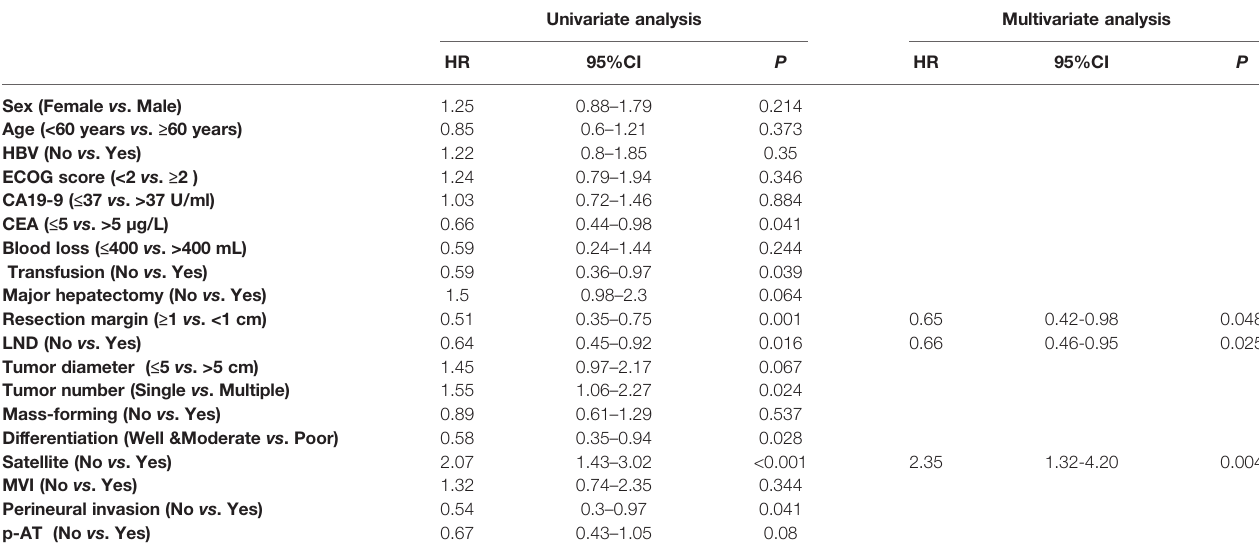
TABLE 3 | Univariate and multivariate analysis of OS in patients with ICC after PSM. Univariate analysis Multivariate analysis HR 95%CI P HR 95%CI P Sex (Female vs .